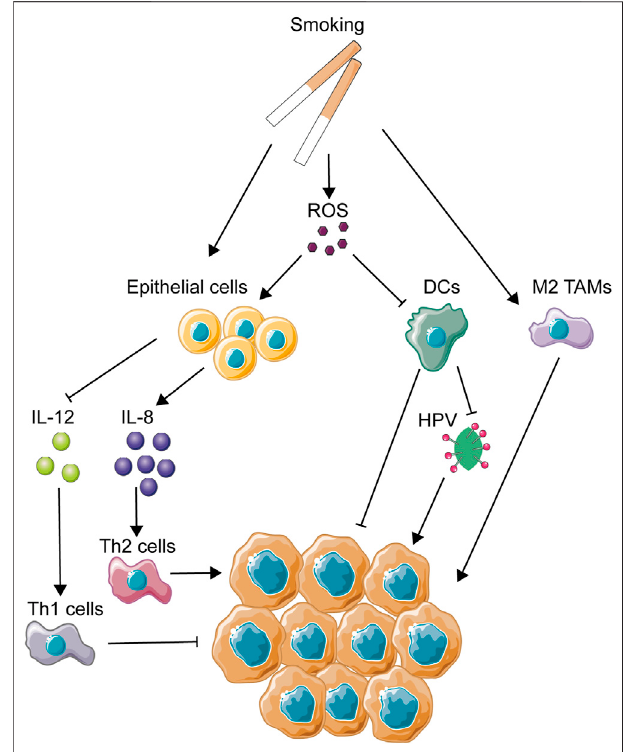
FIGURE 2 | Mechanisms of smoking-related immune regulation in OSCC. This fi gure depicts several main immune-regulating activities associated with smoking. As one of the most important OSCC carcinogens, smoking could directly or indirectly regulate immune activities through activation of epithelial cells and immune cells and the production of